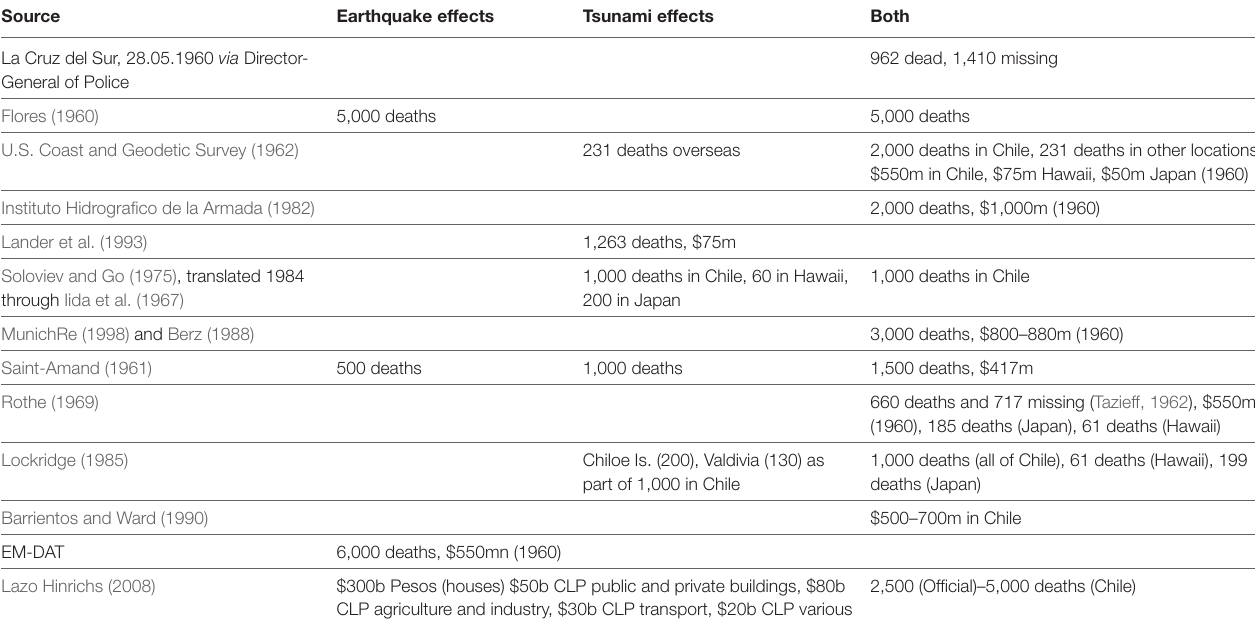
Table 10 | casualty and economic loss information for the 1960 earthquake and tsunami event in chile from various